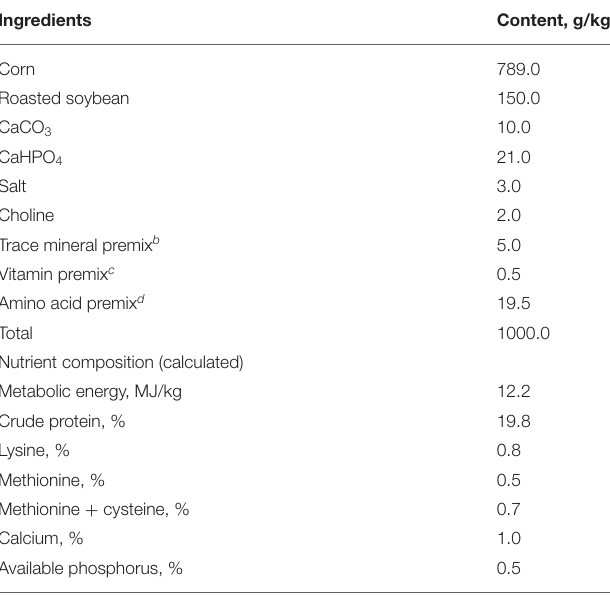
TABLE 1 | Composition of the basal diet (as fed) a